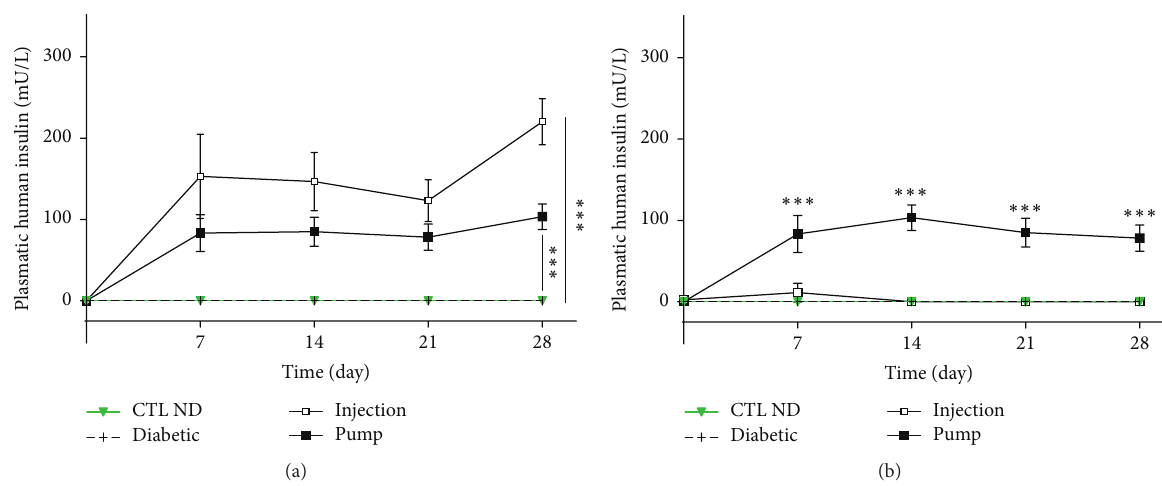
Figure 2: Plasma levels of human insulin at 5 h (a) and 22 h (b) after insulin administration. For both control nondiabetic (CTL ND) and diabetic rats which received no insulin treatment, human insulin was undetectable at 𝑡 + 5 or 𝑡 + 22 h. At 𝑡 + 5 h, both injection and pump rats presented a high level of detectable insulin, but at 22 h thereafter, only the pump group levels continued to increase while the injection group levels did not. CTL ND and diabetic groups are different from injection and pump groups at all times since 7 days ( 𝑝 < 0.01 ) (a); pump group is different from all other groups at all times since 7 days ( 𝑝 < 0.01 ) (b). ∗∗∗ 𝑝 < 0.01 .